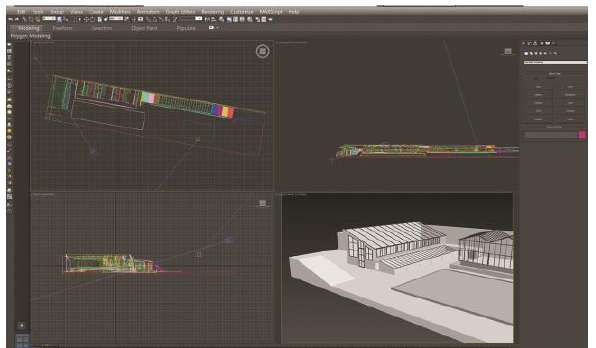
Figure 5. The Royal Park of Tirana. 3D model of the greenhouses realized by the digital platform.